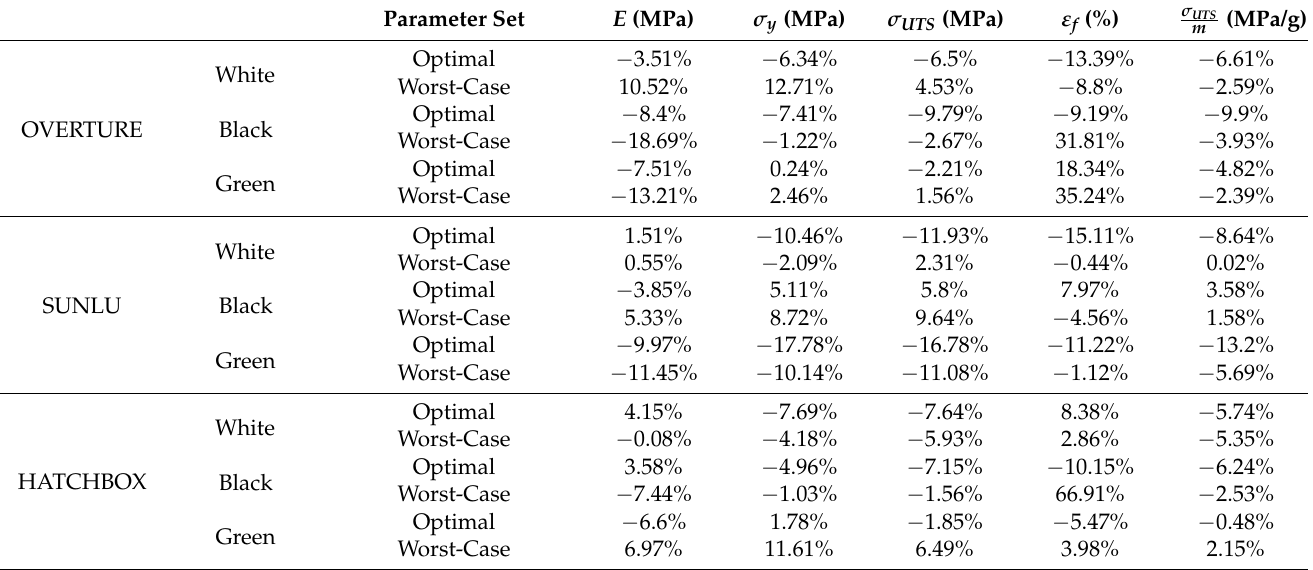
Table 8. Percent differences in mechanical properties (with original units provided) between the annealed and as-printed tensile specimens for each filament for both the optimal and worst-case parameter